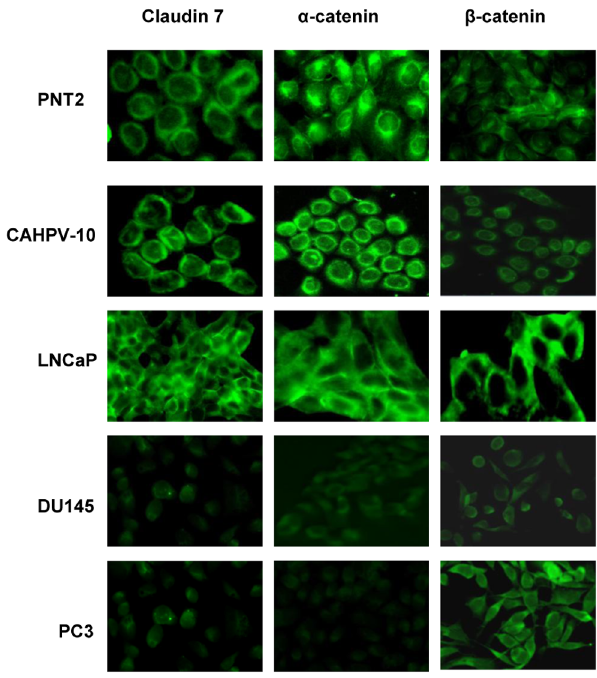
Figure 3. Fluorescence images of PNT2 and CAHPV-10 cells show membrane bound localisation of Claudin 7, a - catenin and b -catenin. For LNCaP cells, protein localisation occurs at the cell membrane and staining intensity appears similar to PNT2 (with the exception of b -catenin, which appears to have a higher expression). In DU145 cells, expression for all proteins is reduced and localisation is diffuse and cytoplasmic. For PC-3 cells, Claudin 7 and a - catenin, fluorescence is markedly reduced and/or cytoplasmic in distribution, while b -catenin fluorescence is stronger but also cytoplasmic in its